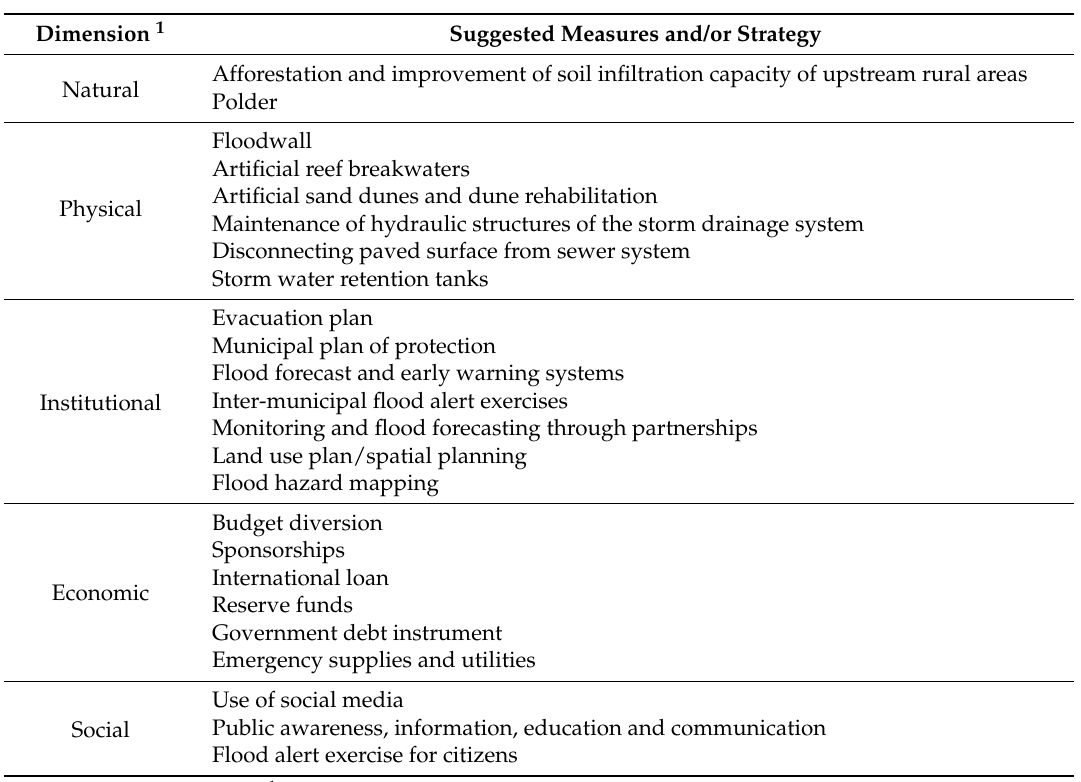
Table 4. Suggested measures from authorities that would increase resilience per dimension if